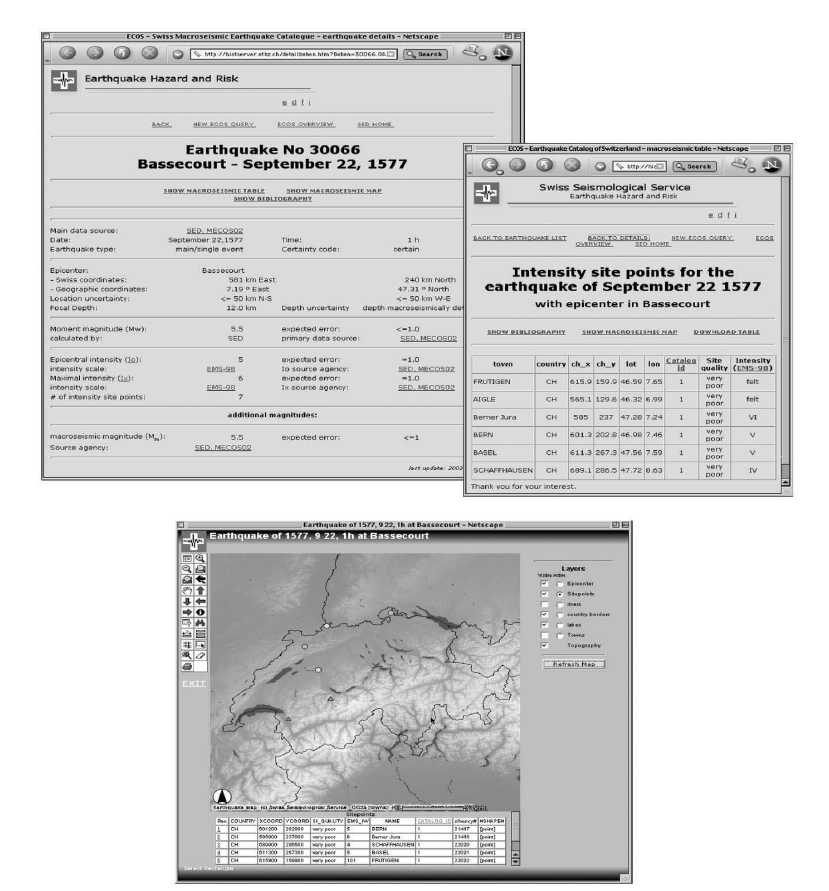
Fig. 4. ECOS query by earthquake: main parameters of the event, IDP list and macroseismic